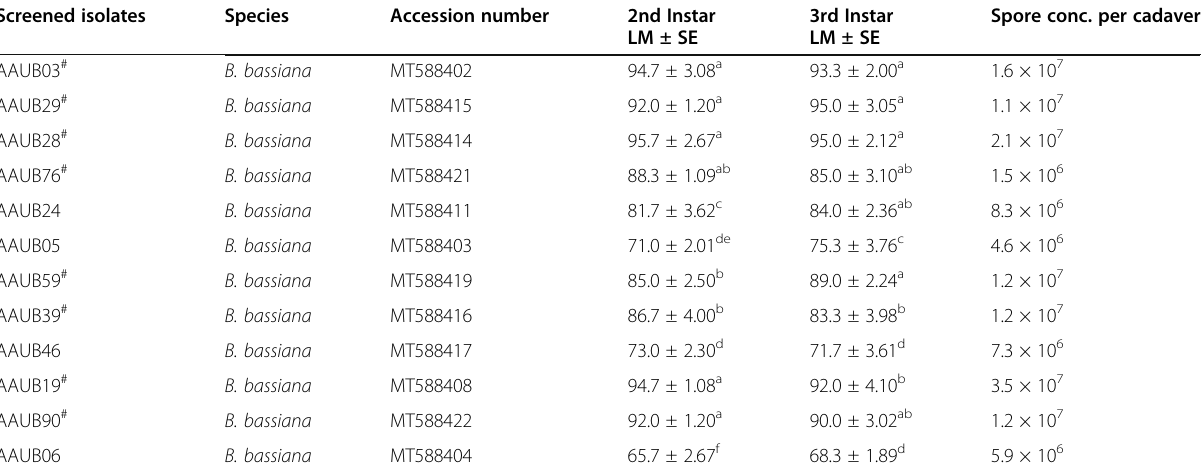
Table 2 Pathogenicity percentage of isolates against second and third larval instars of Tuta absoluta at 1 × 10 7 spores·ml -1 concentration in 7 days post inoculation and sporulation potential over the cadavers Screened isolates